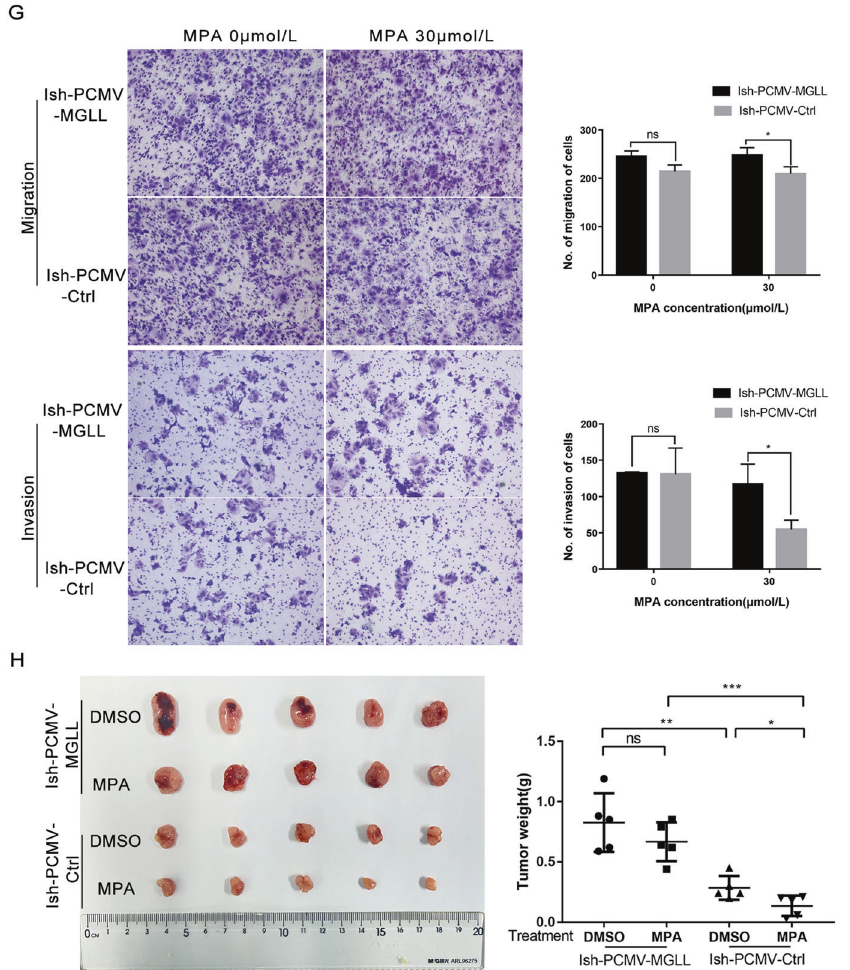
Fig. 4 MGLL overexpression counteracts the sensitivity of EAC cells to progesterone. A Western blot assay was used to detect the protein expression of MGLL in Ish-PCMV-MGLL and Ish-PCMV-Ctrl cells. B qRT-PCR assay was used to detect the mRNA expression of MGLL in Ish- PCMV-MGLL and Ish-PCMV-Ctrl cells. C MTT assay was used to detect the viability of Ish-PCMV-MGLL and Ish-PCMV-Ctrl cells with different- dose MPA. D The proliferation capacity of Ish-PCMV-MGLL and Ish-PCMV-Ctrl cells with 0 or 60 μ M MPA treatment by EDU assay. E Apoptotic cells in Ish-PCMV-MGLL and Ish-PCMV-Ctrl groups with 0,60 μ M MPA for 48 h respectively. Apoptosis was detected by fl ow cytometry after staining with FITC Annexin-V and PI. F Expression of MGLL, CDK4, CyclinD1, Bcl-2, cleaved-PARP and cleaved-caspase3 were determined by western blot assay in Ish-PCMV-MGLL and Ish-PCMV-Ctrl cells were treated with 0.60 μ M MPA for 48 h respectively. G Ability of migration and invasion in Ish-PCMV-MGLL and Ish-PCMV-Ctrl cells treated with 0,30 μ M MPA for 48 h respectively by transwell assay. H The left image shows the tumors transfected with Ish-PCMV-MGLL and Ish-PCMV-Ctrl treated with MPA or DMSO. The right image shows the tumor weights of the four groups of mice. All experiments were repeated three times at least. * P < 0.05, ** P < 0.01, *** P < 0.001, and **** P < 0.0001 for statistical analysis of the indicated